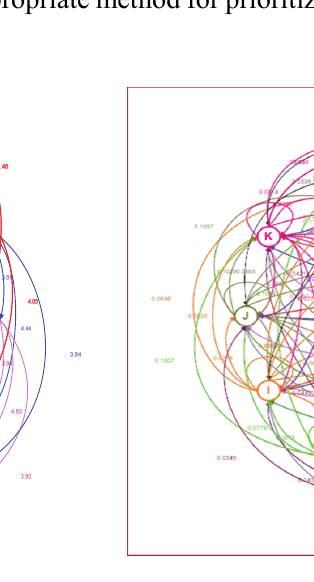
Fig. 2. The results of pairwise comparison Fig. 3. The results of the implementation of DE- MATEL technique